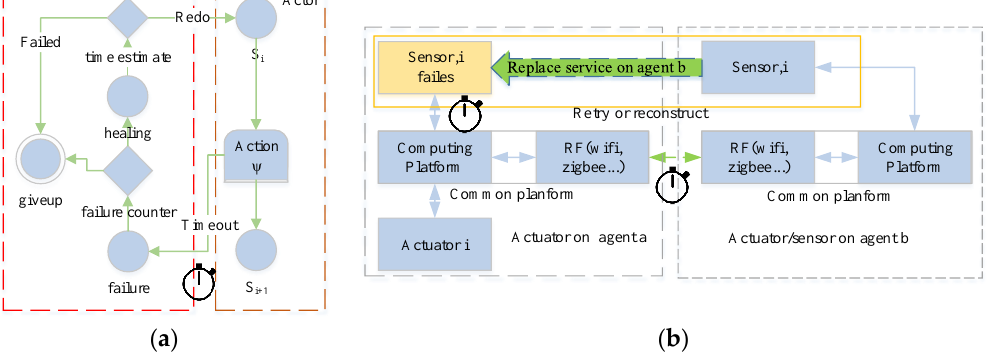
Figure 13. Self-similar healing at actor level and agent level. ( a ) Time based actor level self-healing; ( b ) Time based agent level self-healing.